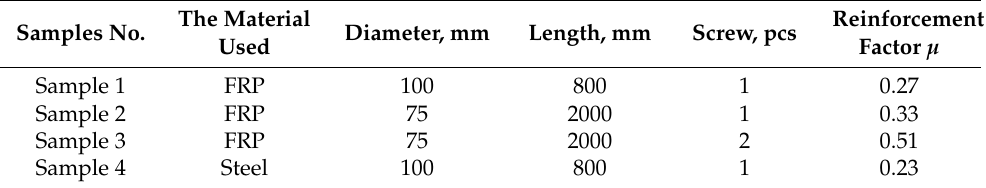
Table 1. The geometrical and material properties of the investigated micropiles.